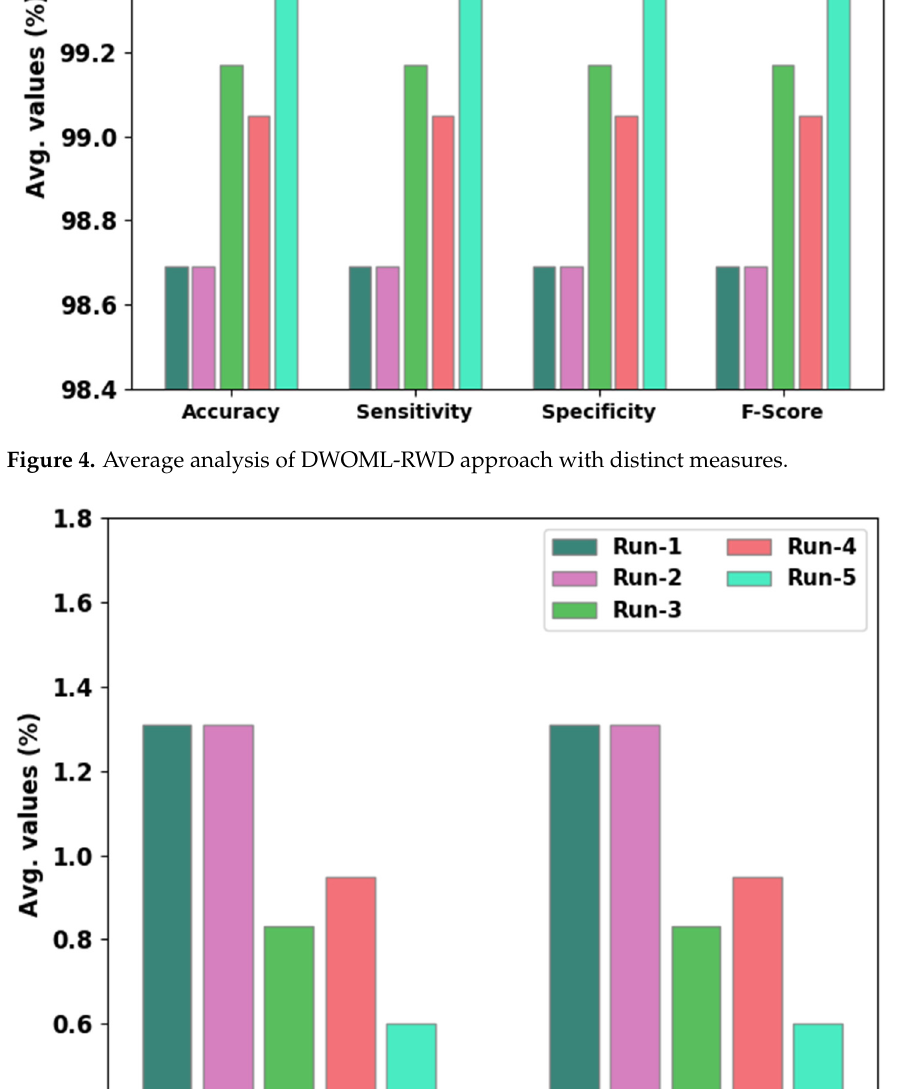
Figure 6. TRA and VLA analysis of DWOML-RWD approach. The training loss (TRL) and validation loss (VLL) attained by using the DWOML- RWD method on the test dataset are exhibited in Figure 7. The experimental outcome